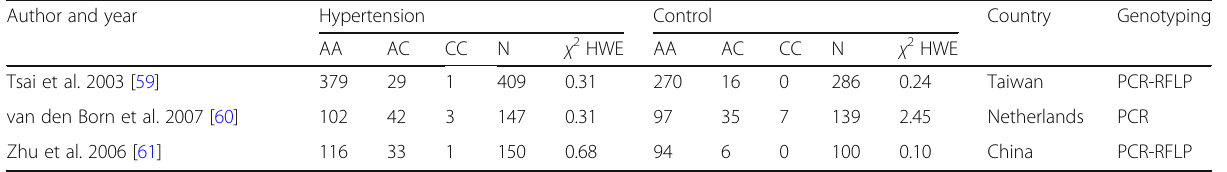
Table 1 Baseline characteristics of studies included in our analysis (Continued)